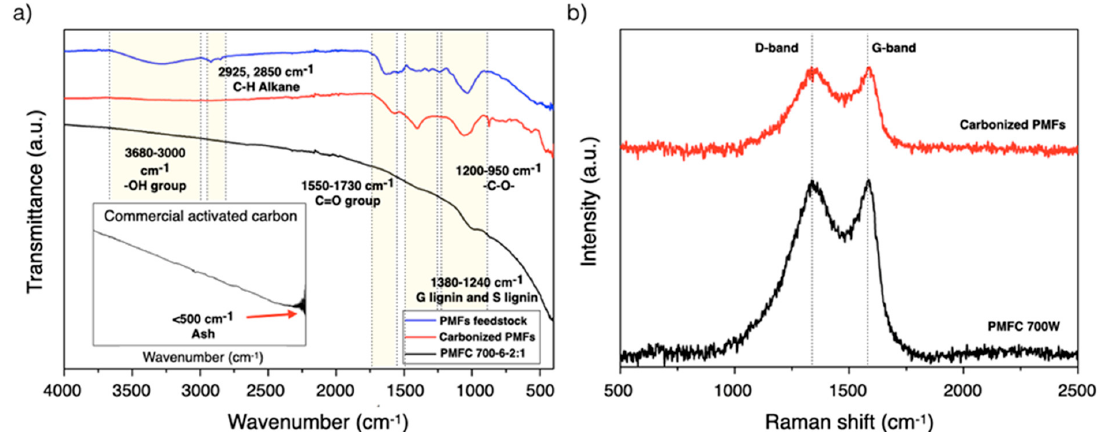
Figure 5. ( a ) Fourier transform infrared spectroscopy (FTIR) spectra of raw PMFs, carbonized PMFs, and PMFC and ( b ) Raman spectrum of carbonized PMFs and PMFC700-6-2:1.